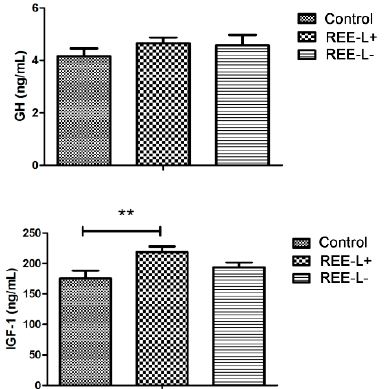
Figure 1. Effect of maternal REE supplementation on growth hormone (GH) and insulin-like growth factor-1 (IGF-1) secretion of their piglets. n = 8 per group. Values are mean ± SEM. ** p < 0.01. REE-L+, REE supplied during gestation and lactation. REE-L-, REE supplied only in late gestation.